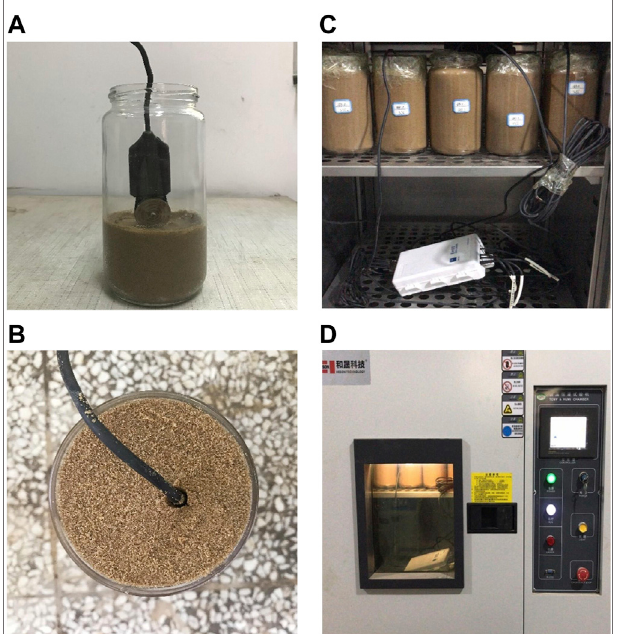
FIGURE 4 | Moisture migration test apparatus.